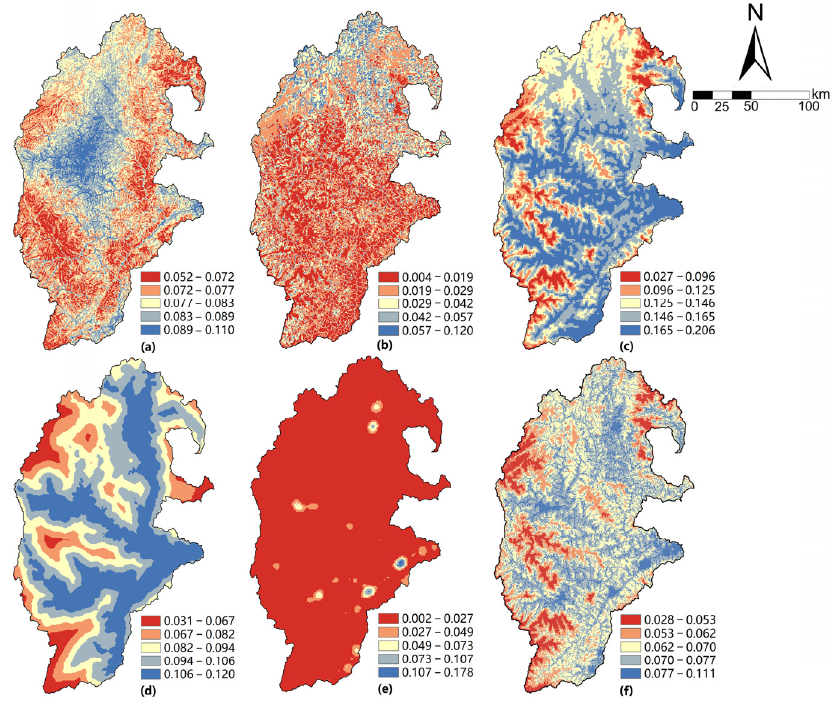
Figure 3. Individual Livability Classification Diagram in the Upper Reaches of the Minjiang River. ( a ) Site security; ( b ) Resources endowment; ( c ) Environmental suitability; ( d ) Living convenience; ( e ) Economic affluence; ( f ) Comprehensive livability.